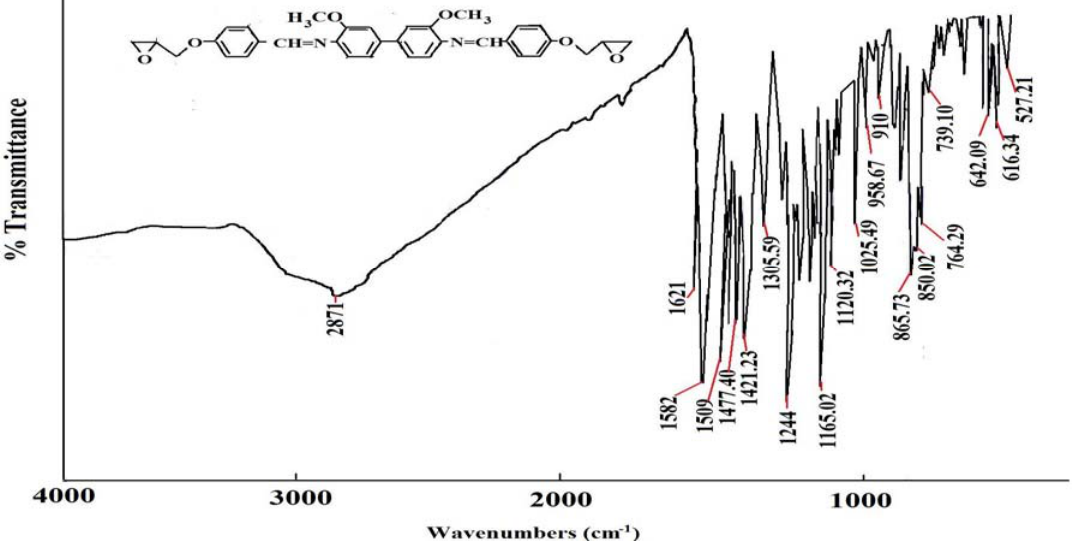
Figure 2. 1 H-NMR spectrum of IIa in CDCl